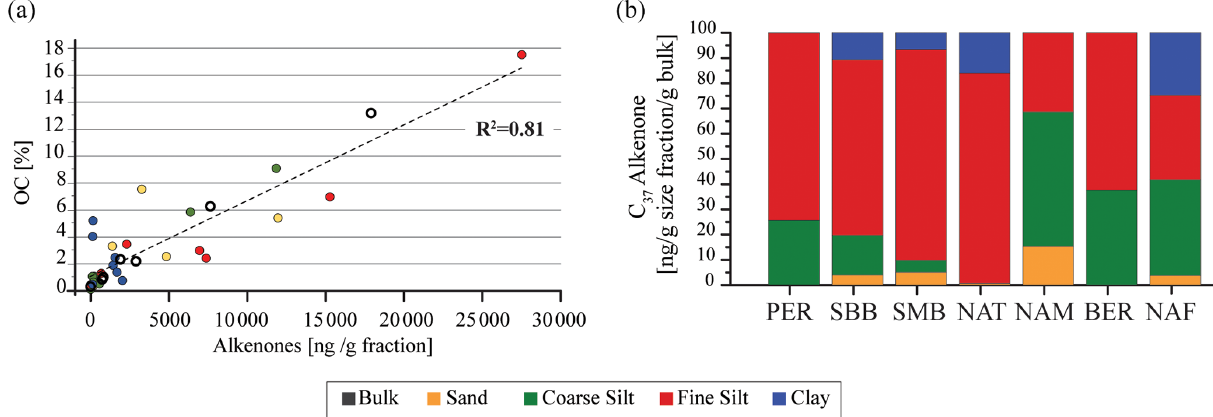
Figure 7. Alkenone correlation with OC % from Ausín et al. (2021) in bulk sediments and grain-size fractions (a) and within each size fraction per gram of bulk sediment (b) .